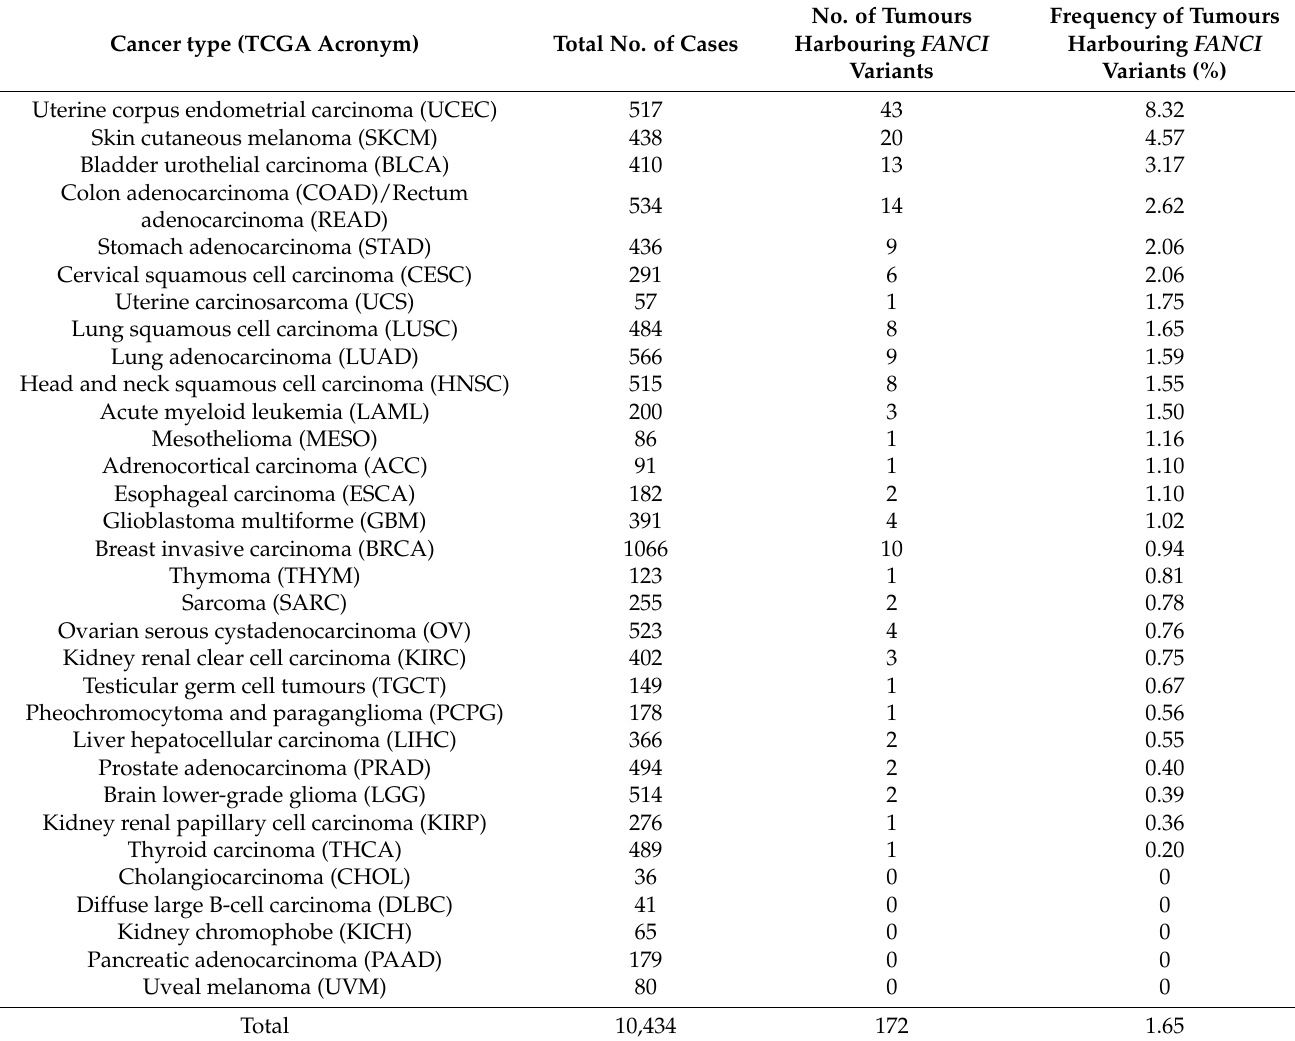
Table 6. Frequency of somatic FANCI variants identified in TCGA PanCancer